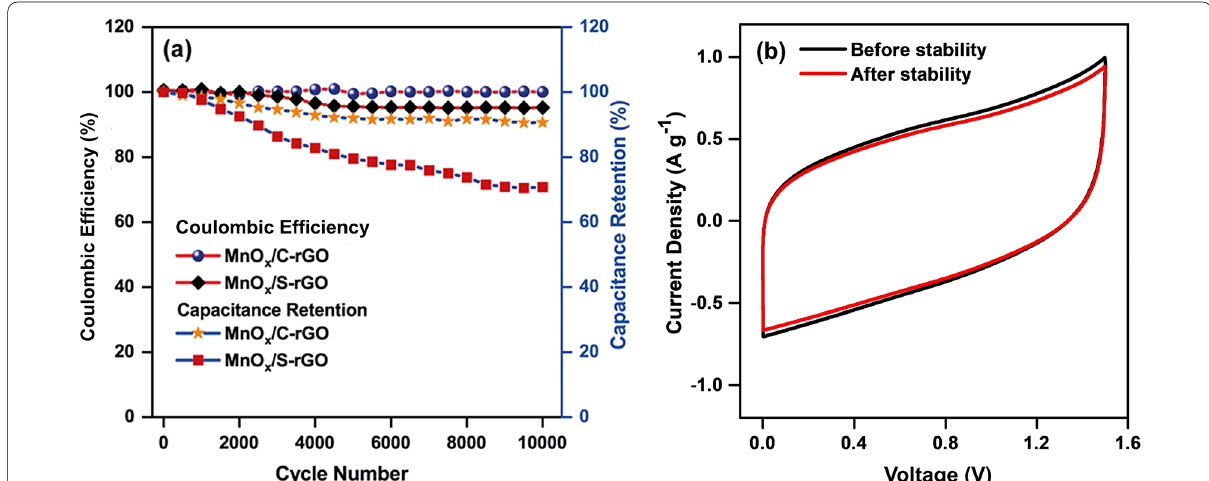
Fig. 5 a Cycling stability of MnO x /S-rGO and MnO x /C-rGO-based symmetric devices. b CV curve of the MnO x /C-rGO-based device before and after stability test at 10 mV s − 1 in 1.0 M Na 2 SO